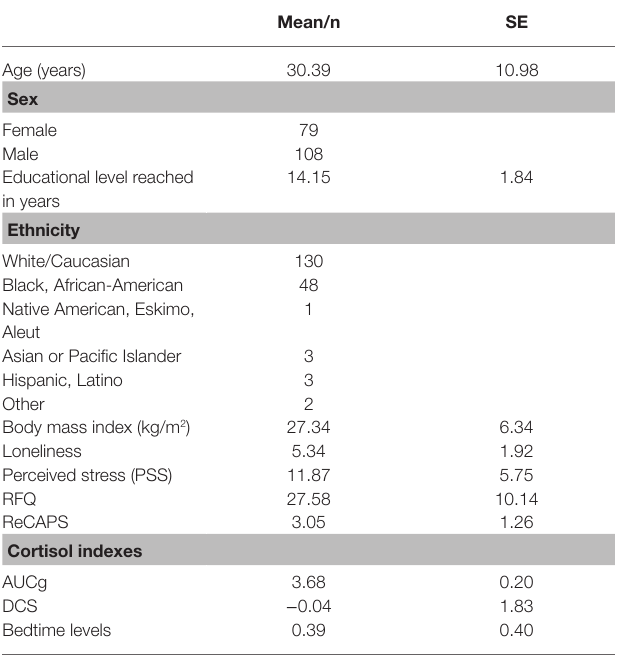
TABLE 1 | Sample characteristics and descriptive